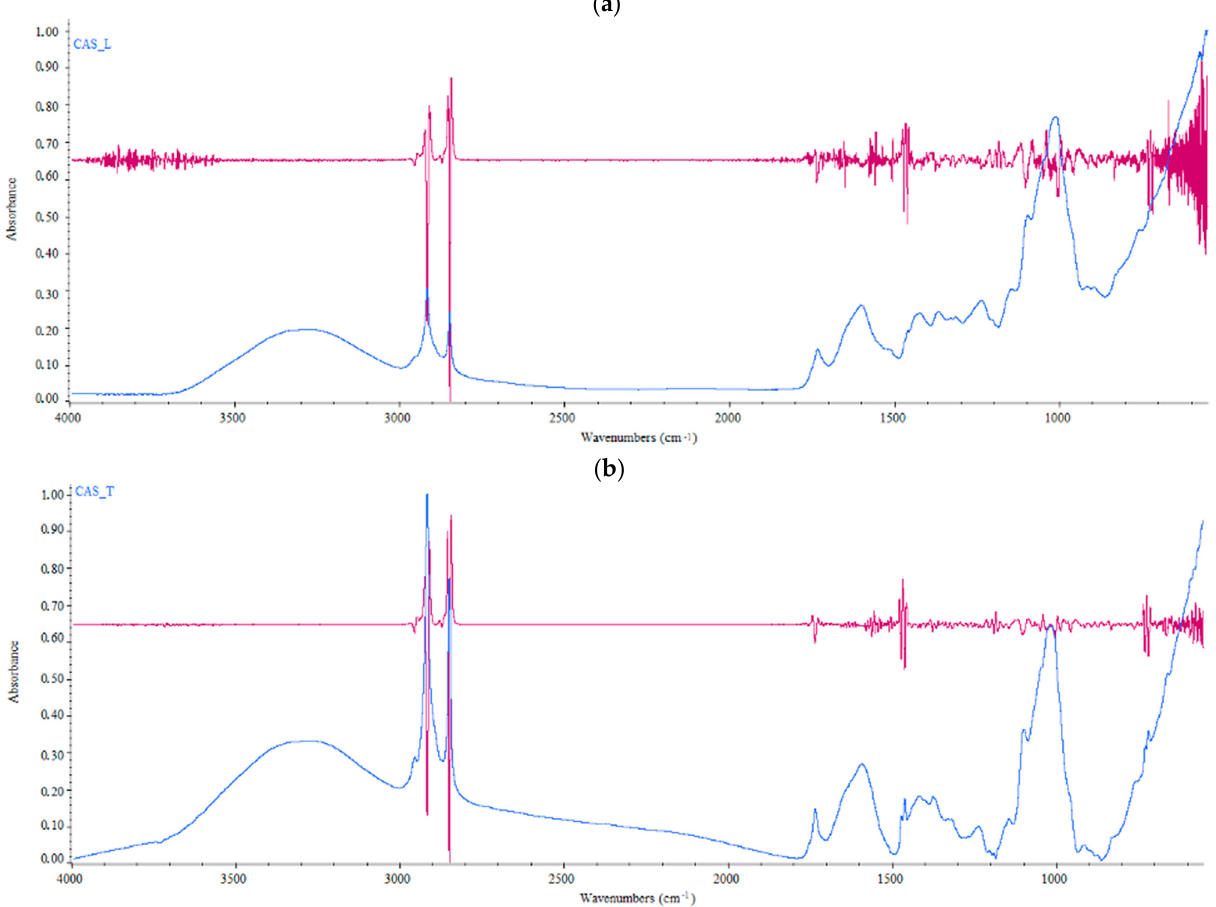
Figure 4. FT-IR raw (blue line) and derivative spectra (red line) of hop samples analyzed: ( a ) Latin hop sample (CAS_L) spectra; ( b ) Tuscan hop sample (CAS_T) spectra.